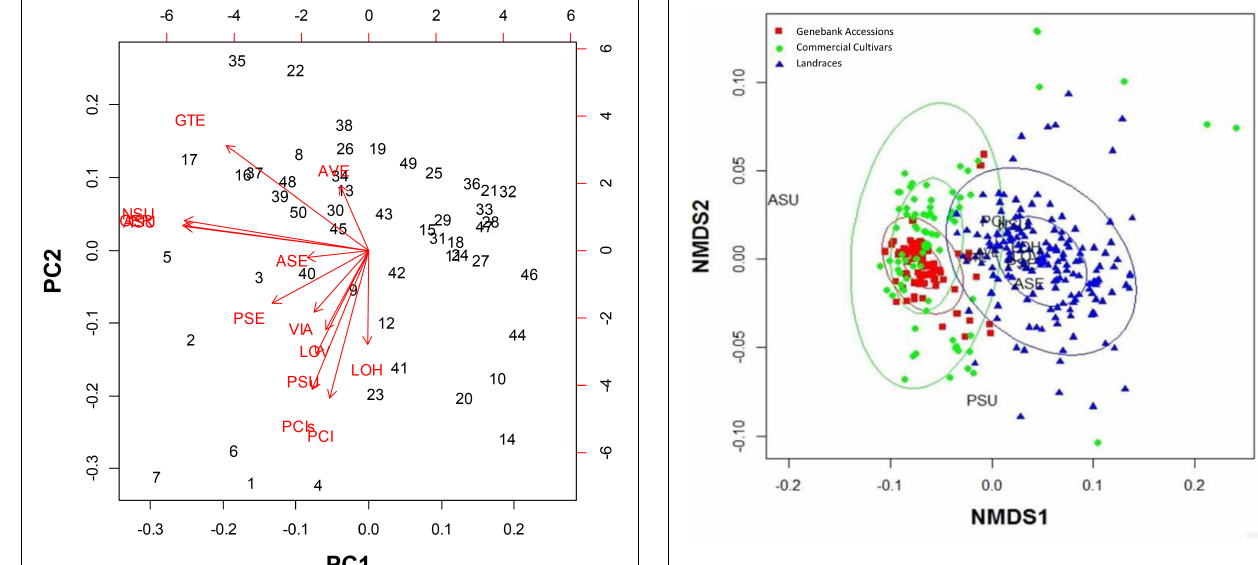
FIGURE 3 | Multidimensional Scaling (MDS) analysis for the seed traits contributing highest variance to the analysis of commercial cultivars, genebank accessions and landraces of purple passion fruit, Passiflora edulis Sims. f. edulis , namely ASU = area of seed pitting, AVE = angle between seed vertices, PCI = fresh dry weight of 100 seeds, GTE = seed coat thickness, NSU = number of seed pits, LOH = length of the seed on the horizontal axis, LOV = length of the seed on the vertical access, PSE = seed perimeter, ASE = seed area, and PSU = seed pit perimeters. Number of measurements: n ( cultivars ) = 80; n ( genebank ) = 280; and n ( landraces ) = 340. while the pulp is higher in sugar content (Devi et al.,